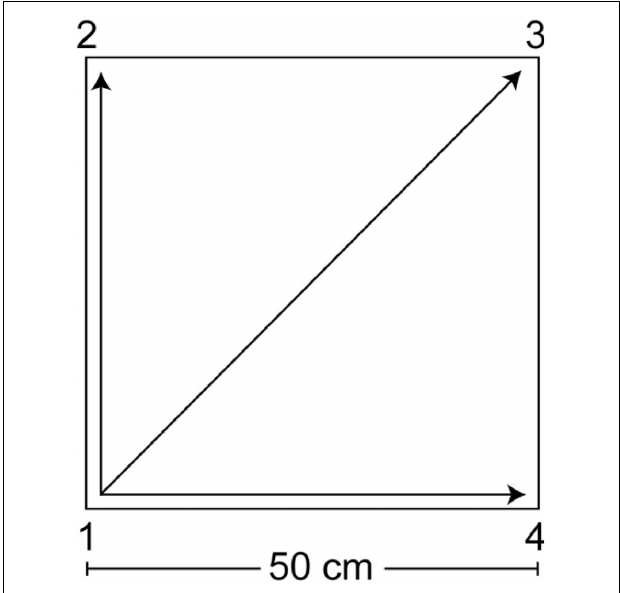
FIGURE 2 | Graphical illustration of the Quadrato Motor Training. The participants stood in a quiet room at one corner of a 0.5 m × 0.5 m square and made movements to the different corners of the square in response to verbal instructions given by an audio tape recording, indicating the next corner to which the participant should move (for example, “one four” means move from corner 1 to corner 4). Participants were instructed to keep their eyes focused straight ahead, their hands loose at the side of the body and to begin all movements with the leg closest to the center of the square. In this longitudinal experimental protocol, the daily training consisted of a sequence of 69 commands lasting 7